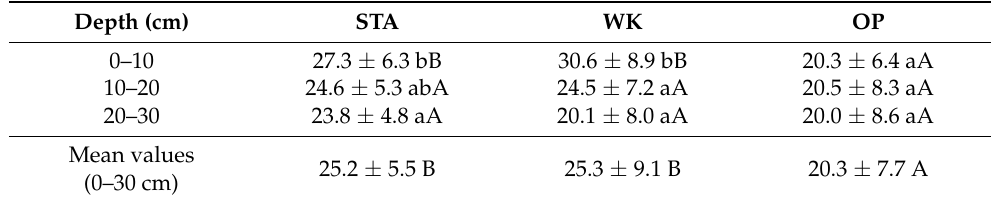
Table 2. Values ± standard deviation of soil water content (%) in three riparian forests in the Vistula River floodplain (STA—Starogr ó d, WK—Wielka K˛epa, OP—Ostr ó w Panie´nski) in three soil layers differences, the small letter for depths, the capital letters for locations ( p < 0.05, Tukey’s test). STA